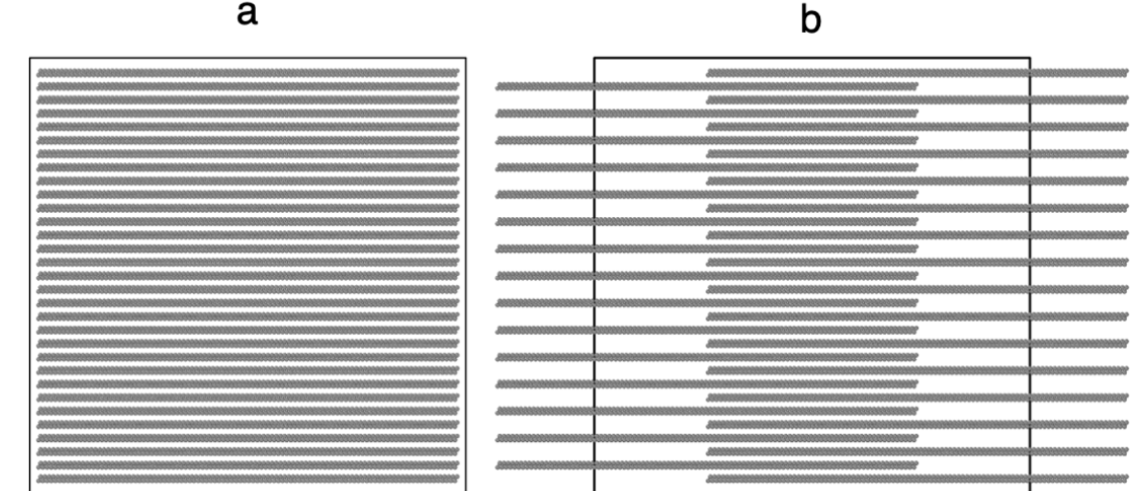
Figure 2. Normal view to the interfacial surface of the representation of uniform ( a ) and non-uniform ( b ) initial configura- tions of a thin layer of linear polyethylene (C 200 ) made of Lennard–Jones sites. The simulation cell used A i = 145 Å × 145 Å with periodic boundary conditions (continuous black line).